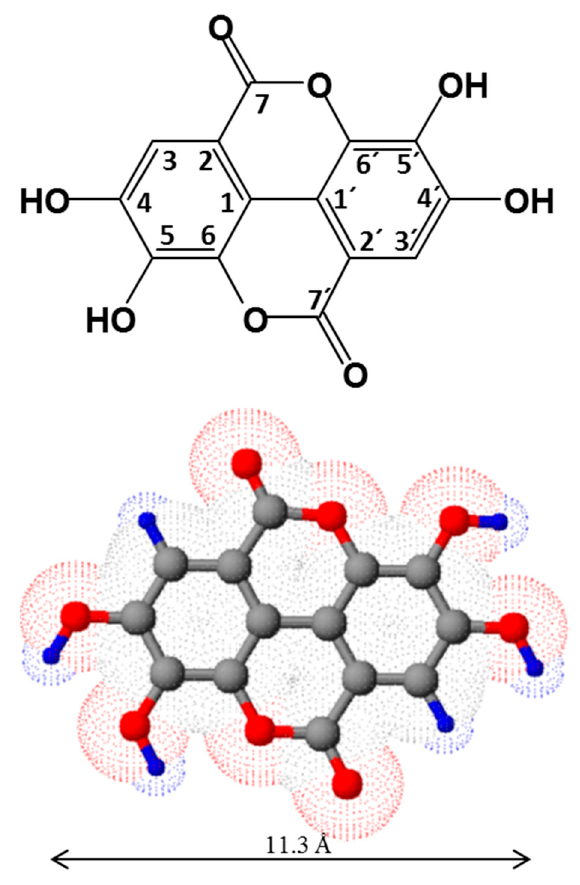
Figure 1. Chemical structure of ellagic acid.